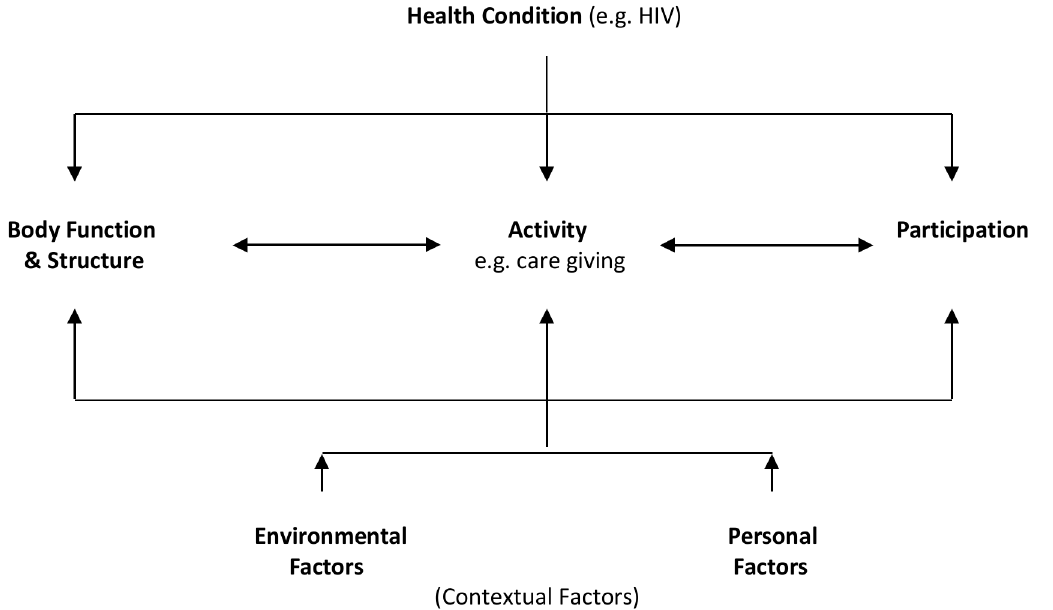
Fig 1. ICF model of function, disability and